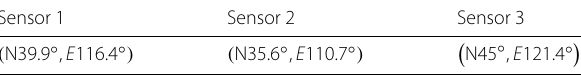
Table 2 The positions of radar sensors Sensor